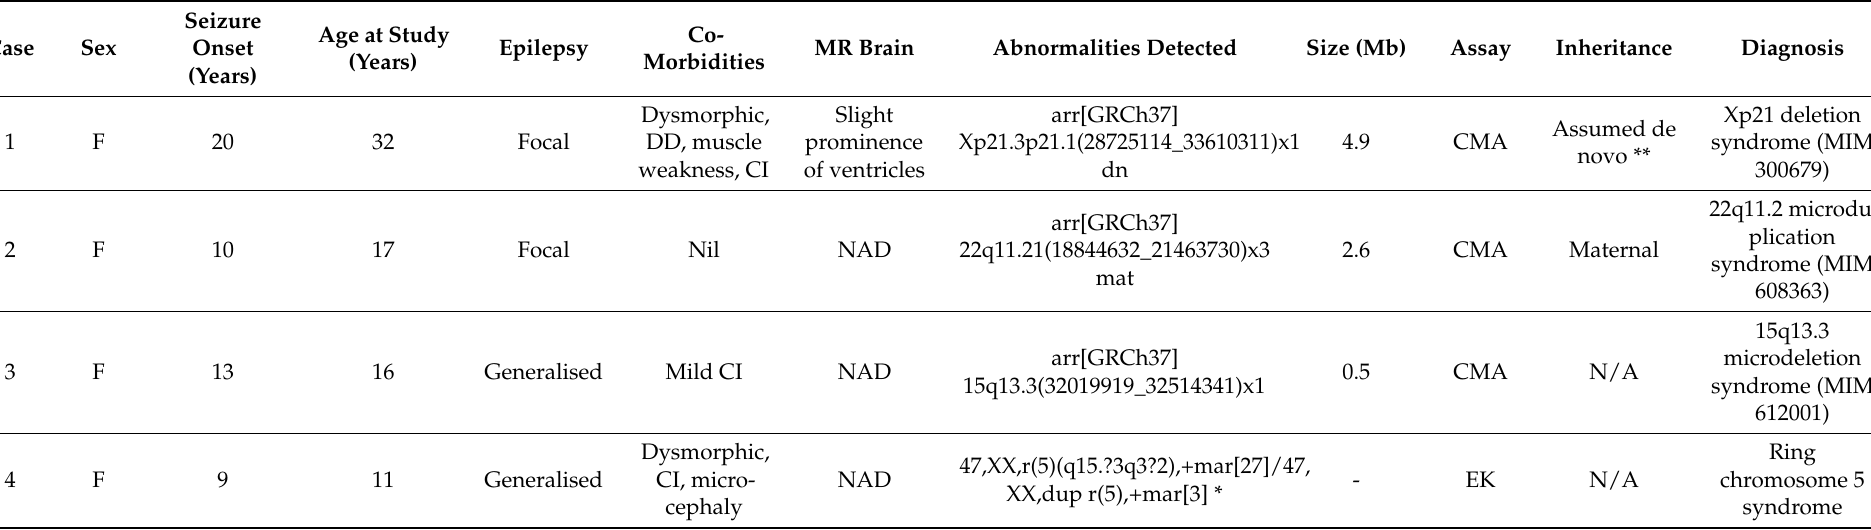
Table 1. Description of the four cases where the genomic diagnosis was obtained using cytogenomic testing (CMA or extended